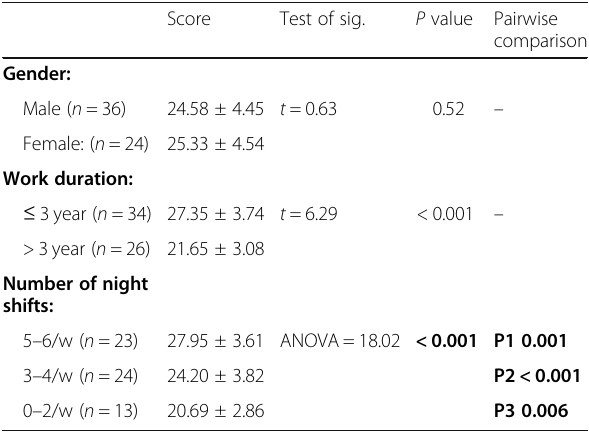
Table 3 Comparison of the mean score of Work Place Stress Scale according to all other parameters Score Test of sig.